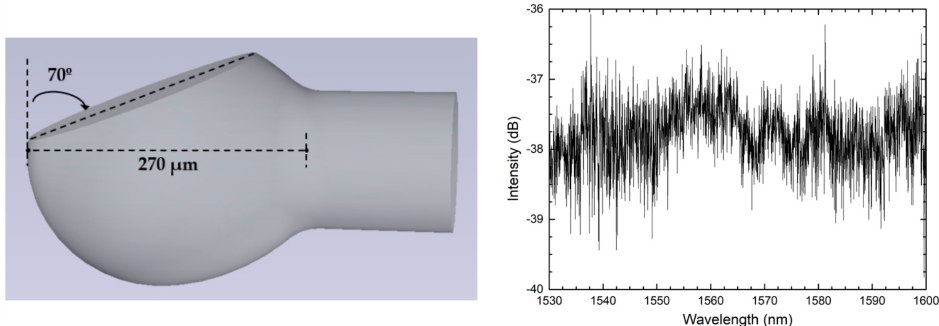
Figure 3. Schematic diagram of the polished microsphere and its reflection spectrum. Reproduced with permission from [9]. IEEE Sensors Letters,